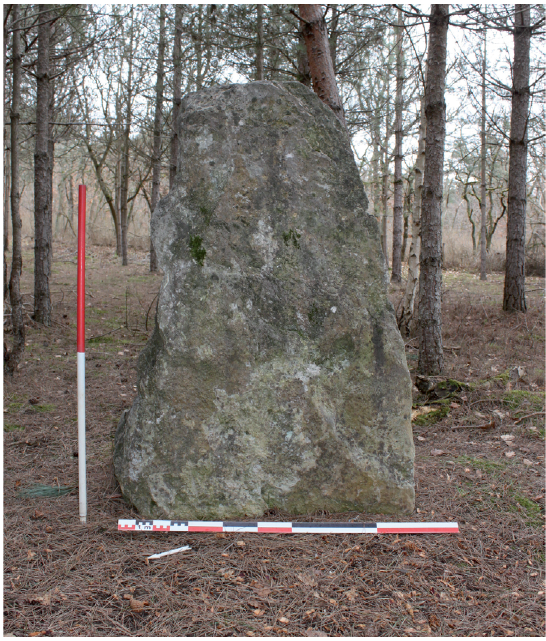
Figure 12. The Pierre Droite : a standing stone recently discovered in Maisse (Essonne) by the GERSAR. © J.